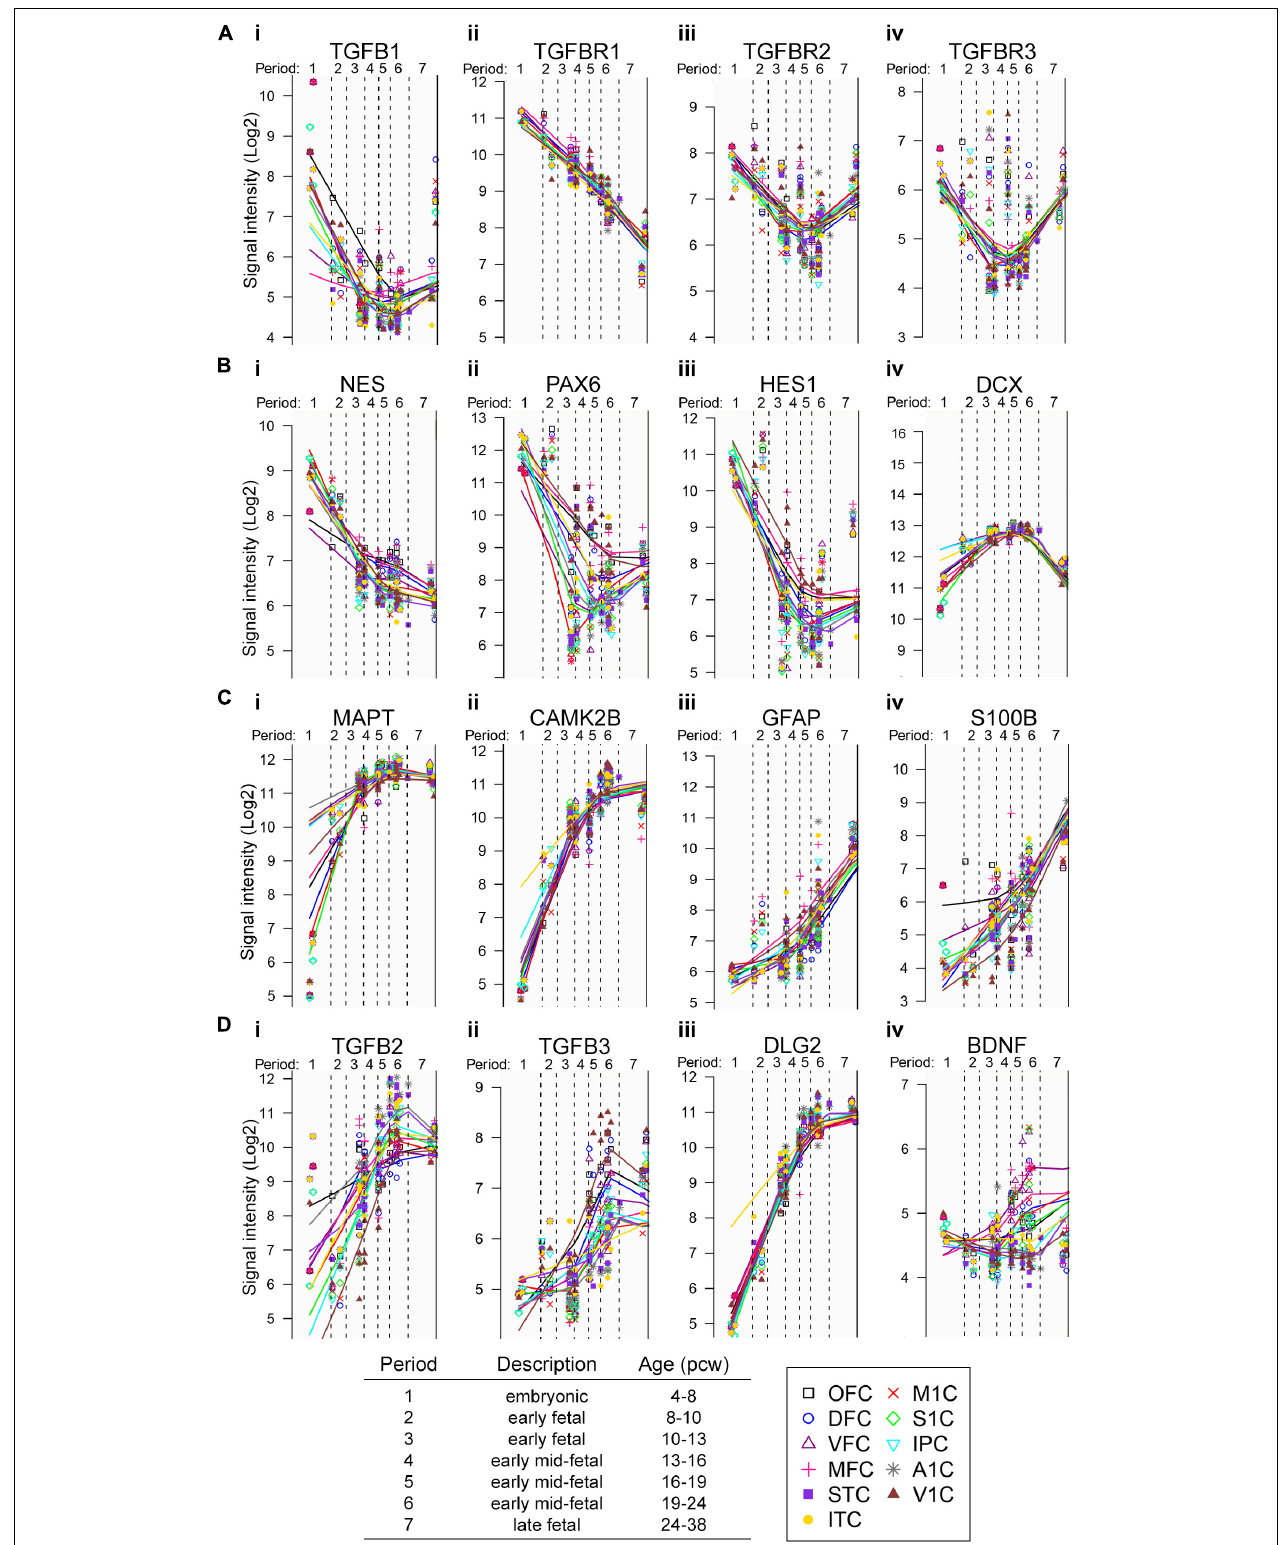
FIGURE 1 | Evidence for relevance of TGF- β signaling in human fetal development. (A–D) Gene-expression profile of transcripts of interest during human prenatal cortical development.